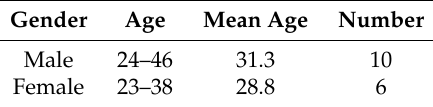
Table 2. Control group: Set of 16